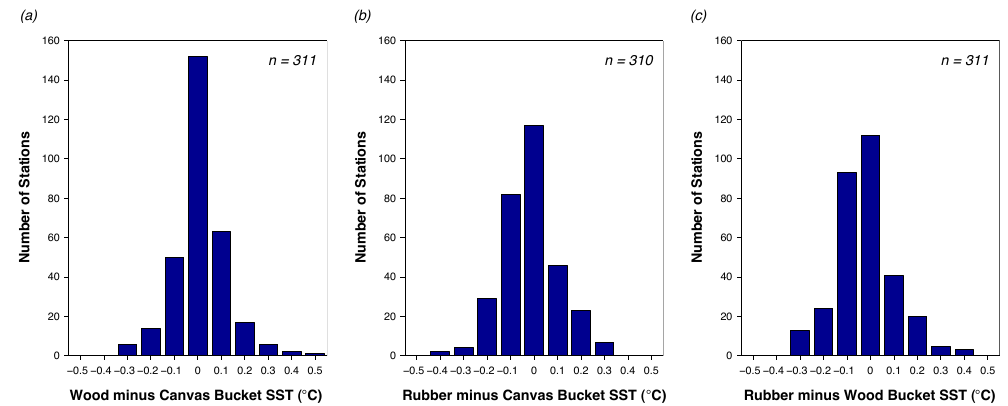
Fig. 3. Histograms of differences between near-simultaneous sea surface temperatures obtained with (a) wood and canvas buckets, (b) rubber and canvas buckets and (c) rubber and wood buckets. A value of 0.7 ◦ C is excluded from (b) , hence this subplot has one fewer total number of stations than (a) and (c) . Table 1. Average upper 3m temperature differences and eastward surface velocities in various current regimes encountered along the cruise transect. The regimes exhibit distinct differences in surface current velocity and/or direction. Four currents were recognised along the transect: the South Equatorial Current (SEC), the South Equatorial Countercurrent (SECC), the North Equatorial Countercurrent (NECC) and the North Equatorial Current (NEC). Adjectives in regime names describe relative current strength in sub-branches of these currents. Regime Approximate Eastward Composite bucket SST latitudinal 19m current minus 3m temperature ( ◦ C) range ( ◦ N) velocity (cms − 1 ) All